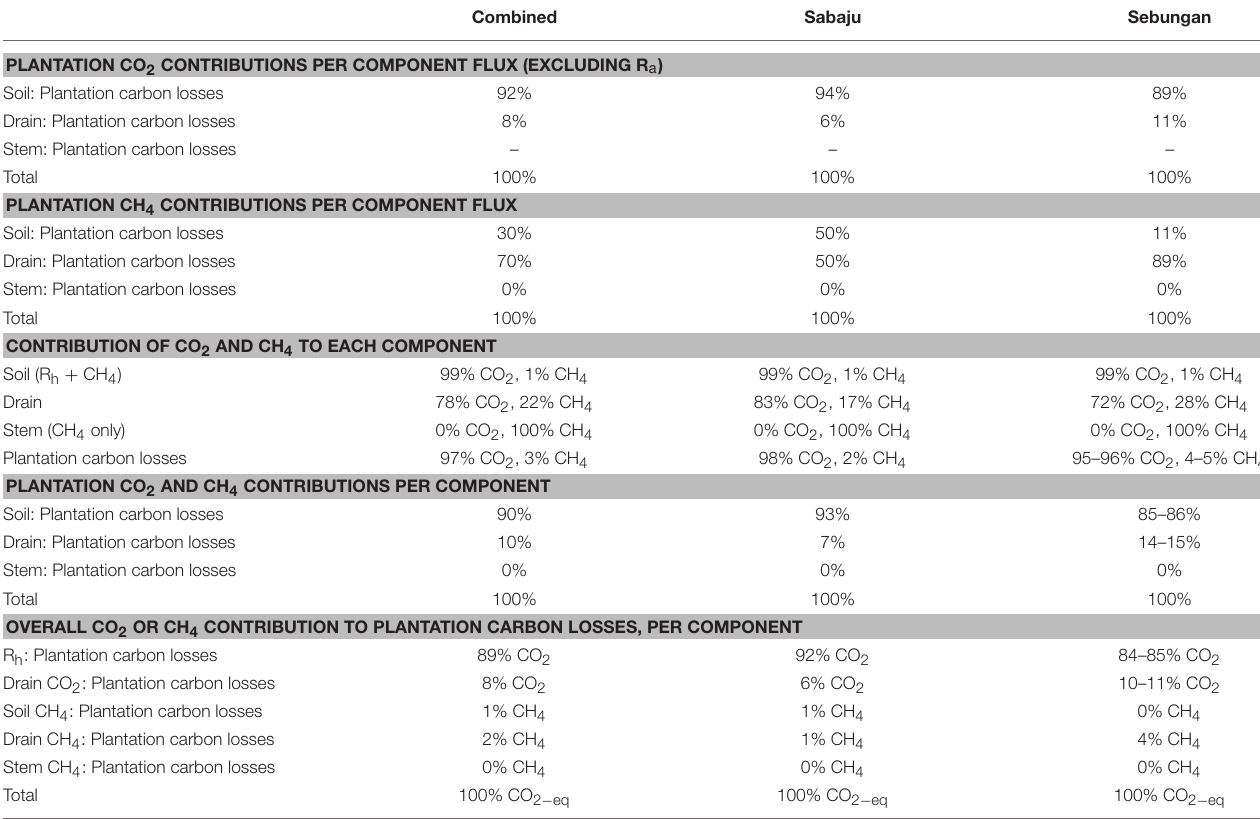
TABLE 6 | Percentage contributions of the soil, drain, and stem components to plantation CO 2 , CH 4 and CO 2 − eq fluxes.